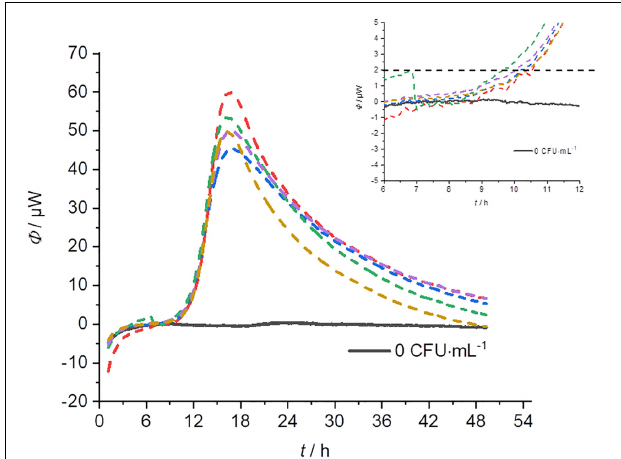
FIGURE 6 | Heat flow signals from L . plantarum on MRS-agar under identical conditions ( c 0 = 10 4 CFU · mL − 1 ). The insert provides a magnification of the beginning of the signal which is important for the determination of the detection time.